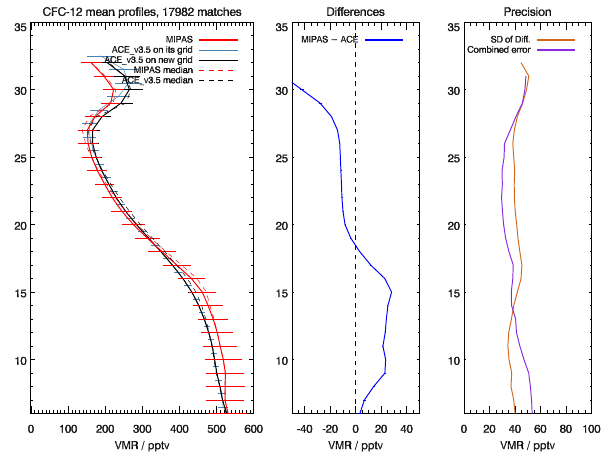
Figure 25. Comparison of mean profiles of MIPAS CFC-12 (left panel, continuous red line) and ACE-FTS (left panel: blue line denotes ACE-FTS on native grid; continuous black line denotes ACE-FTS interpolated onto the MIPAS grid) for the years of 2005– 2012. The error bars include the total error for MIPAS and the ran- dom errors from the least-squares fitting process for ACE-FTS. The dashed lines show the median of each data set. The middle panel shows the mean difference (blue) of these profiles and the standard error of the mean. The right panel shows the combined error (pur- ple) of the instruments and the standard deviation of the differences